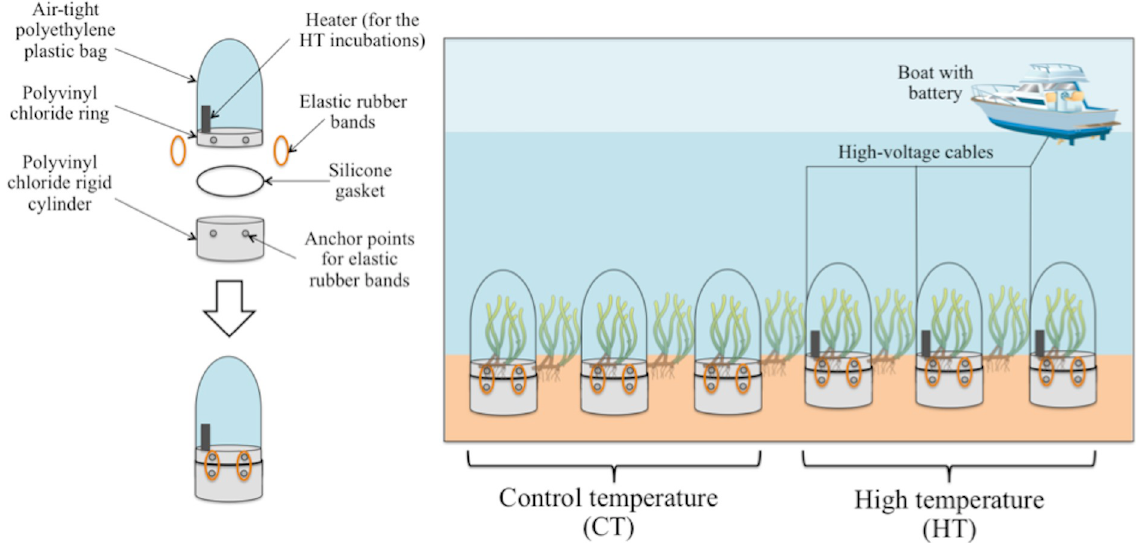
Fig 2. Simplified diagram of the incubations and of the experimental design. See detailed description in the text.